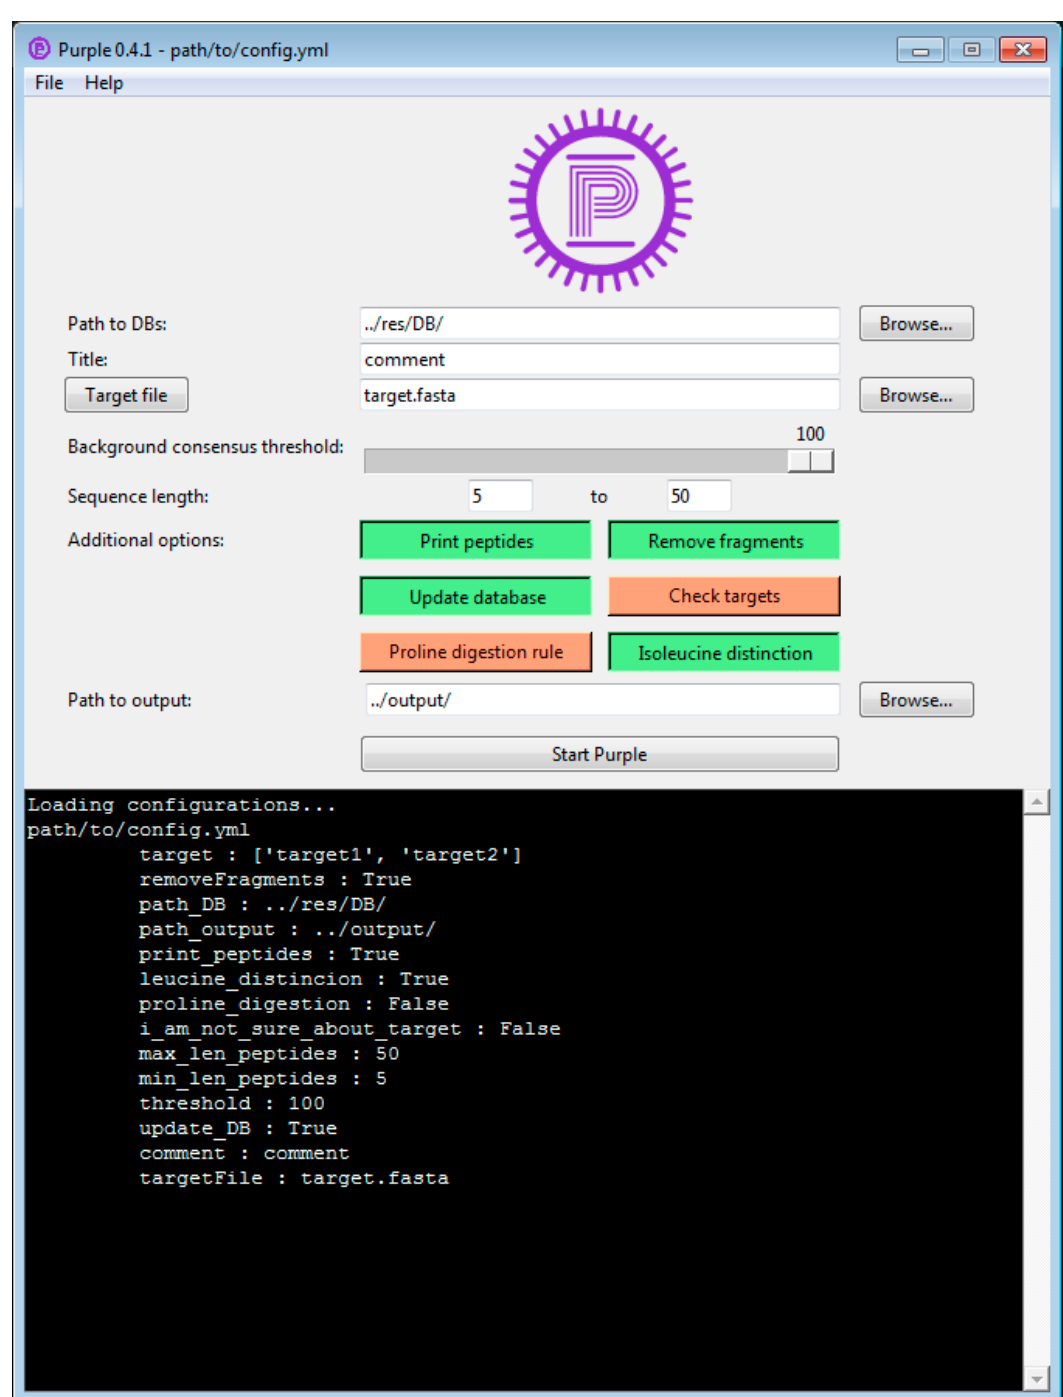
Figure 2. The graphical user interface of Purple. In the top file menu, configurations files can be loaded and saved. The top menu also includes a link to the documentation and manual. The listed GitLab page provides direct user support from the developers via an issue tracking system. The upper panel shows default parameters and allows modifying the configuration settings and processing start. The lower panel displays the current processing status with logging information on the current run, configuration, and progress of the analysis.